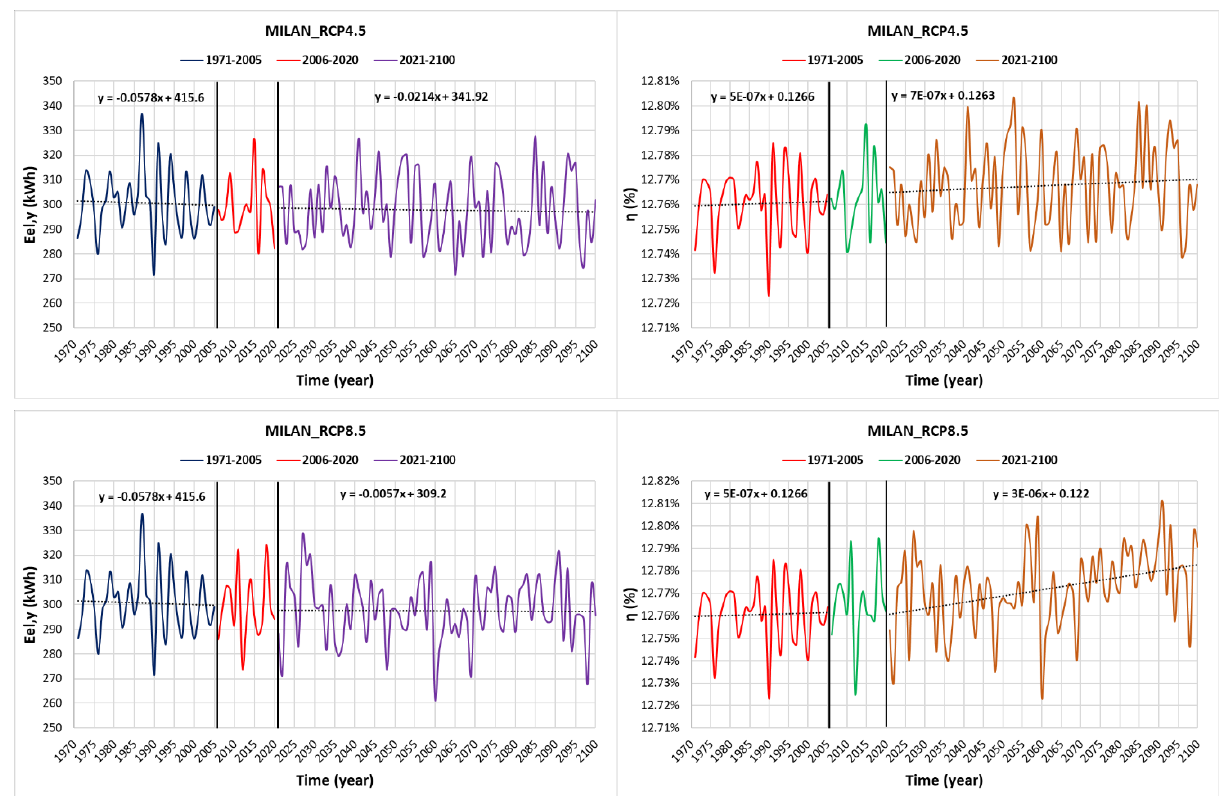
Figure 9. Milan ’ s monthly PV electricity variation in January ( left ) and July ( right ) from 1971 to 2100. ( Top ): RCP4.5, ( bottom ): RCP8.5.